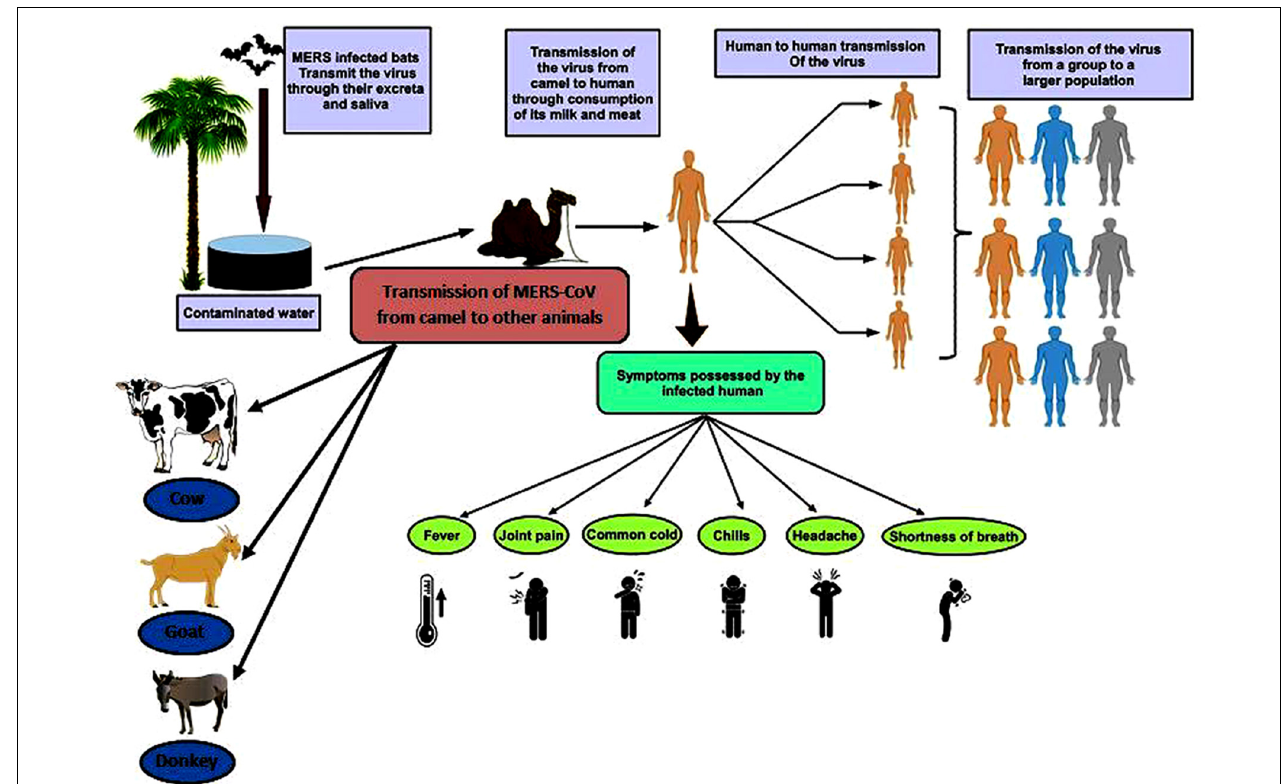
FIGURE 3 | Transmission of MERS-CoV and symptoms possessed by infected human. The figure shows the path by which the virus is transmitted from the infected camel to the human and camel to various animals (Kandeil et al., 2019); further, this virus is transmitted to other human population via human to human transmissions (Shehata et al.,